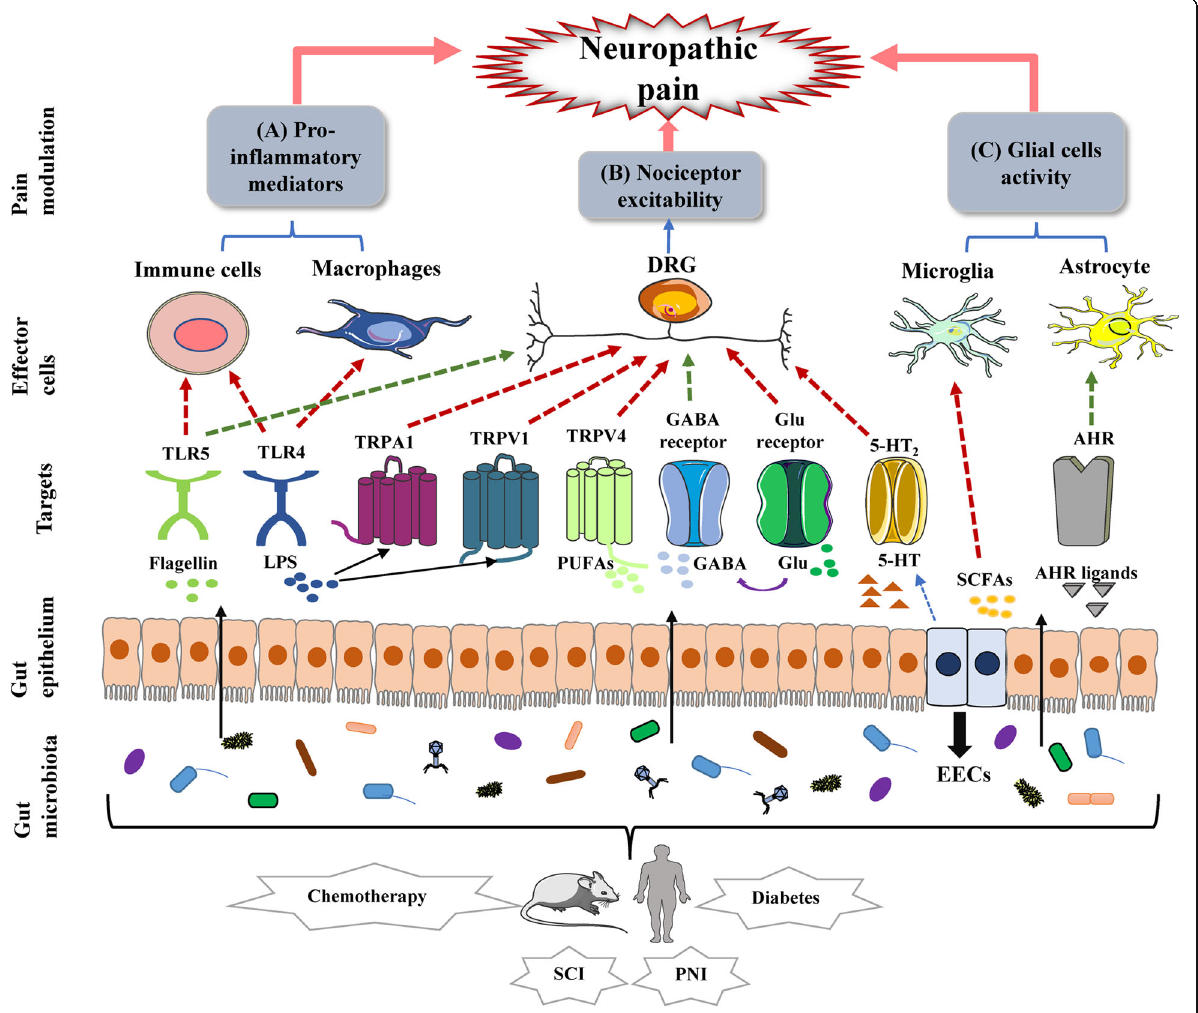
Fig. 2 The potential role of gut microbiota in neuropathic pain. Gut microbiota-derived mediators participate in the modulation of neuropathic pain through three routes: a LPS and flagellin act on immune cells and macrophages through TLR, and lead to the release of pro-inflammatory mediators; b Different mediators alter nociceptor excitability via diverse receptors expressed on DRG neurons; c Metabolites regulate glial cells activity directly or through AHR. The red dotted line represents exacerbating pain and the green one represents alleviating pain. Abbreviations: DRG, dorsal root ganglion; TLR, Toll-like receptor; TRPA1, transient receptor potential cation channel, subfamily A, member 1; TRPV1, transient receptor potential cation channel, subfamily V, member 1; TRPV4, transient receptor potential cation channel, subfamily V, member 4; GABA, γ - aminobutyric acid; Glu, glutamate; AHR, aryl hydrocarbon receptor; LPS, lipopolysaccharide; PUFAs, polyunsaturated fatty acids; SCFAs, short-chain fatty acids; ECCs, enteroendocrine cells; SCI, spinal cord injury; PNI, peripheral nerve